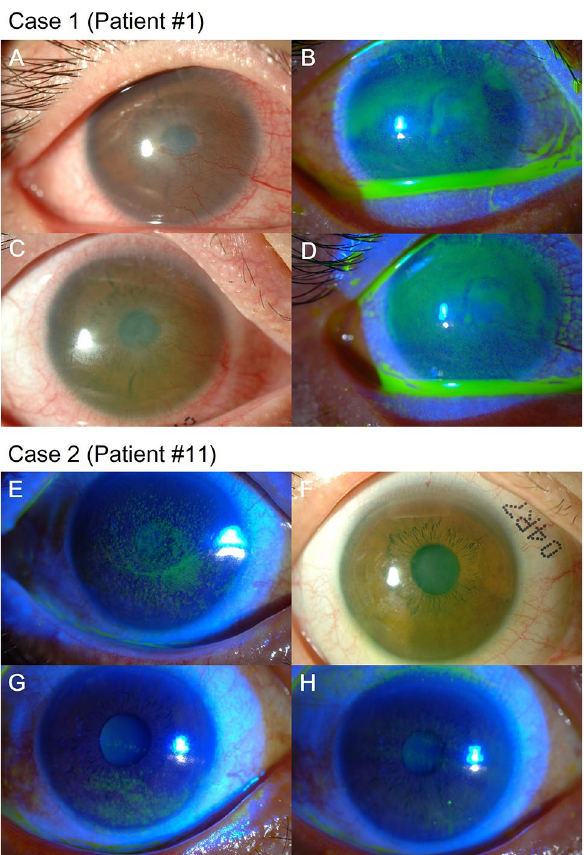
Figure 4. Representative photos of enrolled subjects. Case 1 (Patient #1) shows the right eye of a 23-year- old male with SJS that occurred 6 years ago after taking cold medication. At presentation, both the UCVA and BCVA were 0.82 logMAR. Anterior segment photographs without and with fluorescein application at presentation are shown in ( A ) and ( B ), respectively. LK scleral lens fitting was appropriate with no vascular compression as shown in ( C ). The BCVA after 1 week significantly improved to 0.15 logMAR, which was stably sustained throughout the entire 12-week study period. The corneal fluorescein staining score did not show any significant difference from baseline ( D ). Case 2 (Patient #11) show the left eye of a 53-year-old female with cGVHD that occurred after allogeneic bone marrow transplantation for acute myeloid lymphoma. At presentation, both the UCVA and BCVA were 0.40 logMAR with diffuse corneal punctate epithelial erosions ( E ). LK scleral lens fitting was appropriate with no vascular compression as shown in ( F ). With the LK scleral lens, the erosions had grossly decreased at week 1 ( G ) and continued to improve with only minimal erosions remaining by week 12 ( H ). BCVA was − 0.08 logMAR at week 1, which was maintained until the end of the study. BCVA: Best-corrected visual acuity, cGVHD: chronic graft-versus-host disease, logMAR: log of minimal angle of resolution, SJS: Stevens–Johnson syndrome, UCVA: uncorrected visual